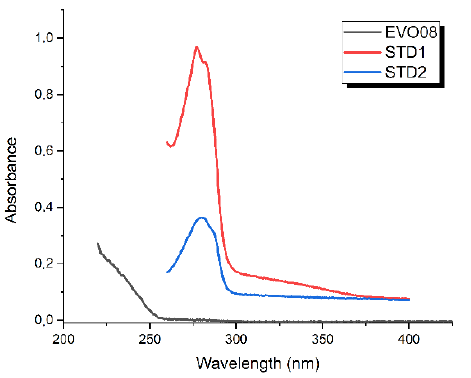
Figure 5. UV-Vis absorbance spectra of EVOO8 (black), STD1 (red) and STD2 (blue), in hexane µ L sample to 50 mL solution (20 μ L sample to 50 mL solvent). solution (20